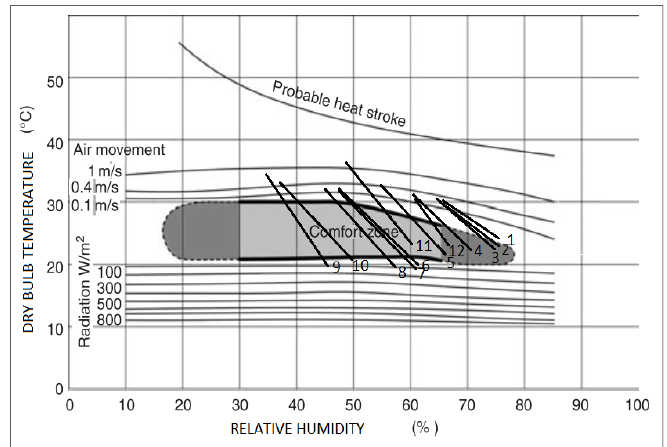
Figure 4. Olgyay Bioclimatic chart of Jakarta.